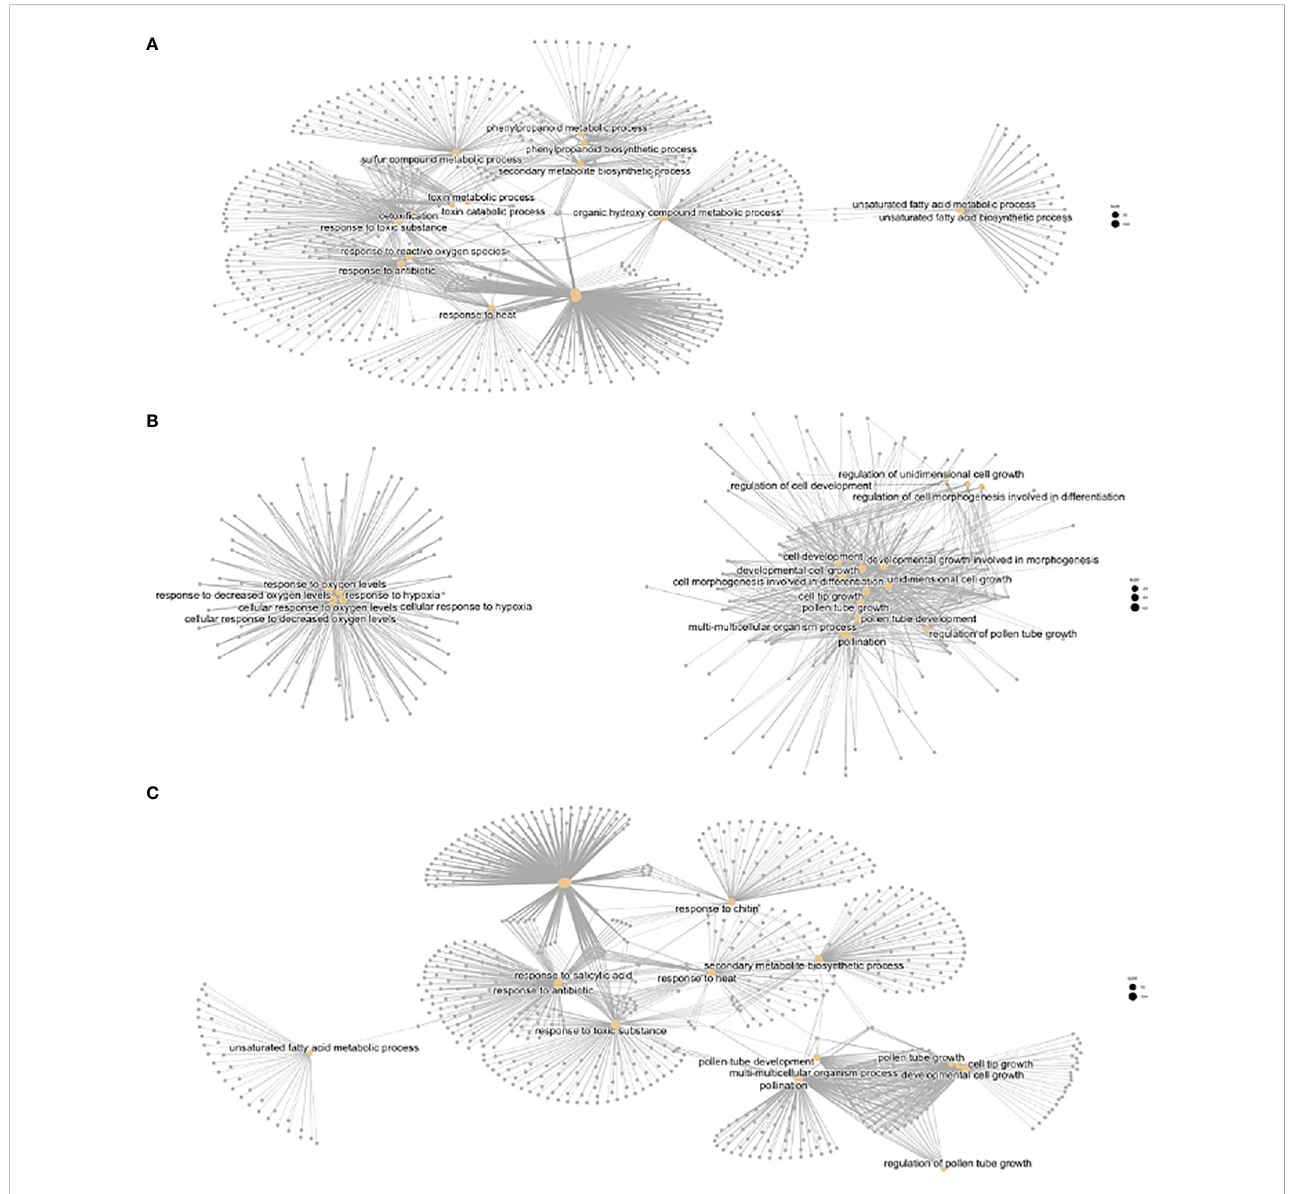
FIGURE 5 CNET plots of Biological Functions with differential regulation. (A) Heat vs control, (B) cold vs control, (C) heat vs